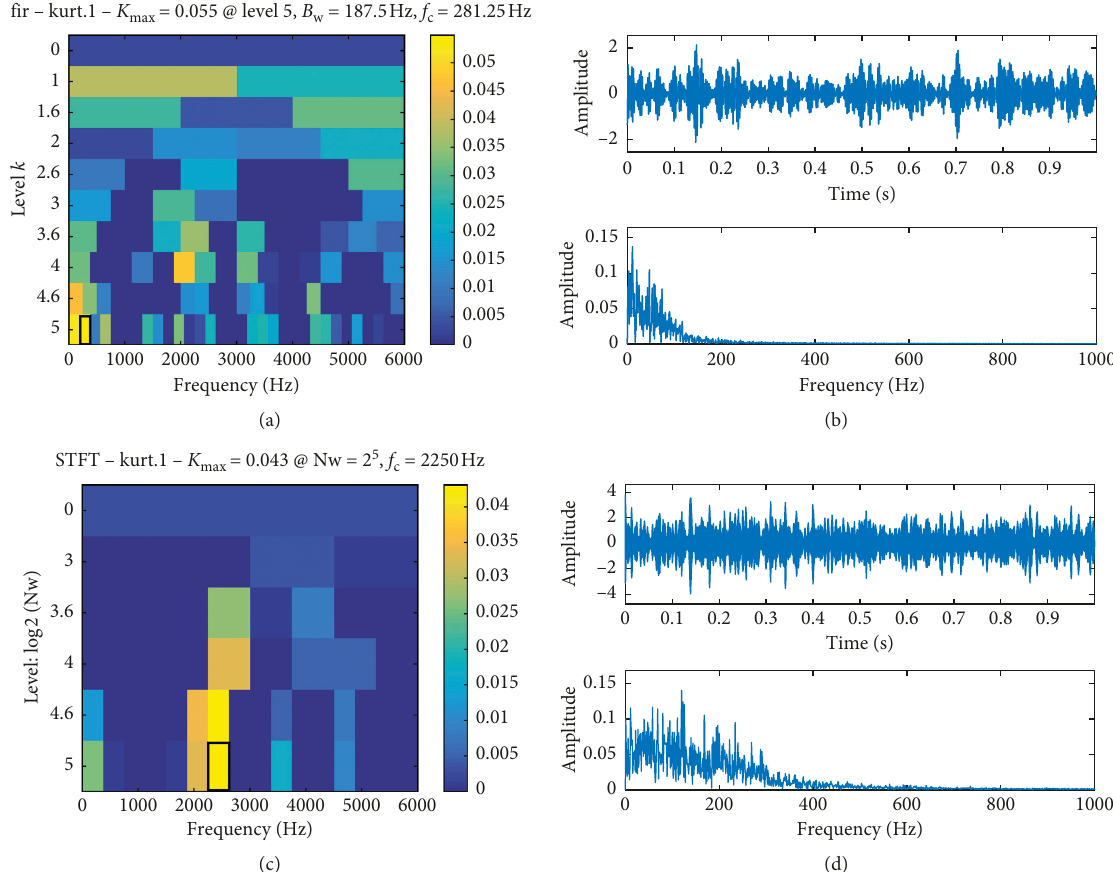
Figure 11: Fast kurtogram based on (a) FIR and (c) STFT; signal component and its envelope sequence by (b) FIR and (d)